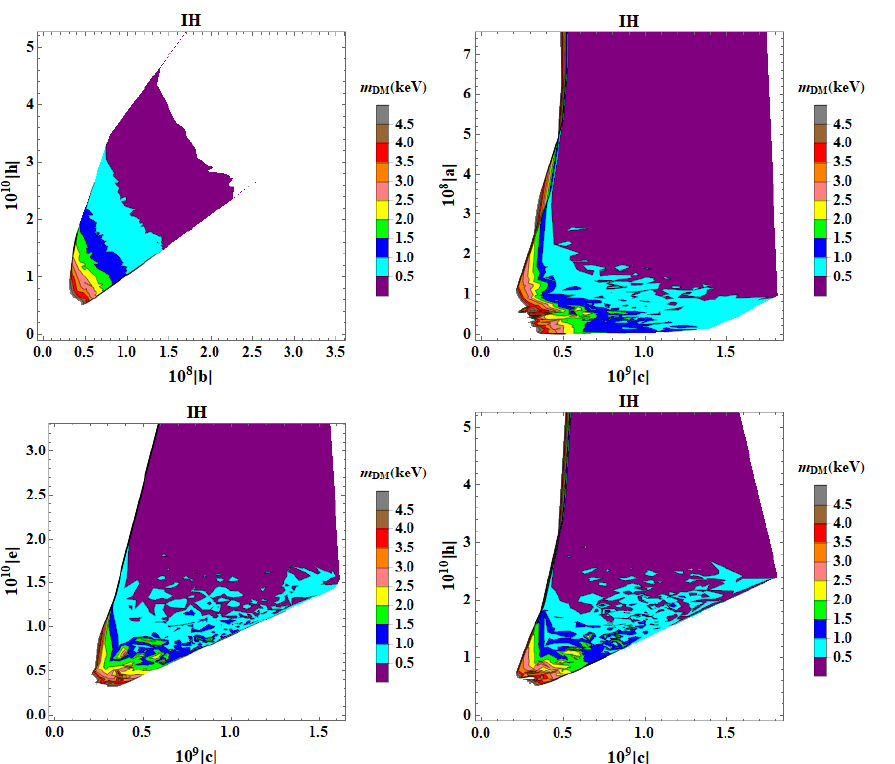
Figure 8 . Variation of di(cid:11)erent model parameters (in eV) with Dark Matter mass as a contour for inverted hierarchy The mass limit as predicted by cosmology is (0 : 4 (cid:0) 50)keV.